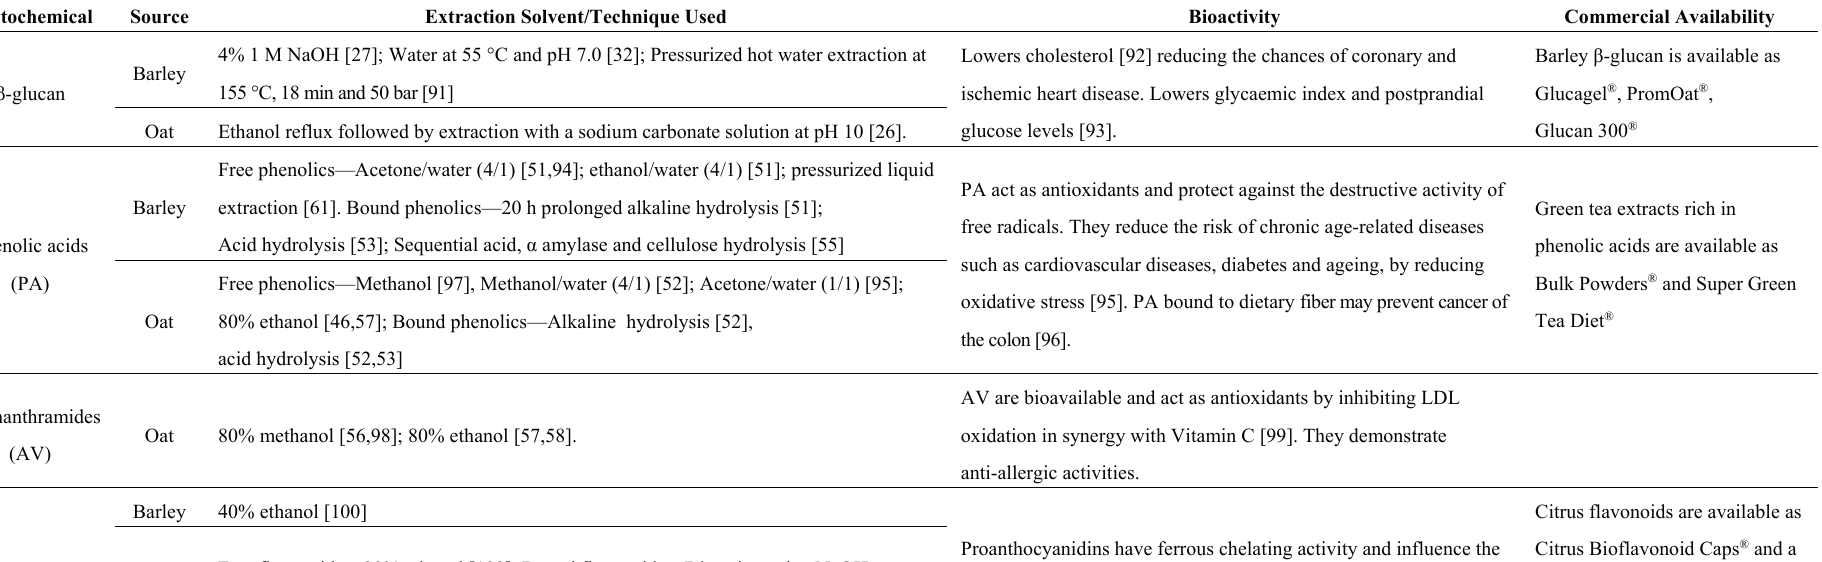
Table 2. Phytochemicals present in barley and oats, methods used for extracting them and their reported bioactivities. Phytochemical Source Extraction Solvent/Technique